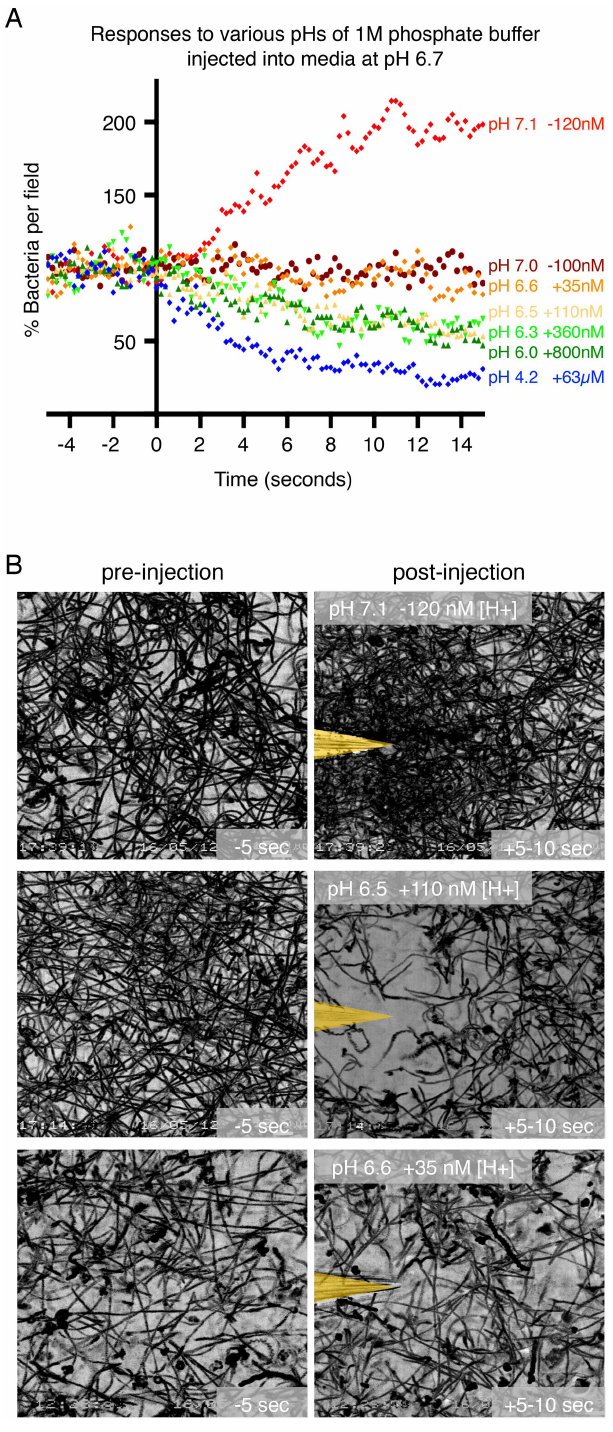
Fig 4. H . pylori can respond to acidic and basic changes in pH with nanomolar sensitivity. ( A ) Quantification of the responses of wild-type(WT) H . pylori to phosphatebuffer solutions with pH rangingfrom 4.2 to 7.1. The addition(+) or depletion (-) of hydrogen ions relative to the hydrogenion concentration in the culture medium (pH 6.7) is indicatednext to the pH of the buffer solution introduced. Each point represents the percent of swimmingbacteria remainingin the field of view at each time point in the digitizedvideo microscopy movie frames. Points for one movie are plotted per condition. Time zero is definedas the moment the